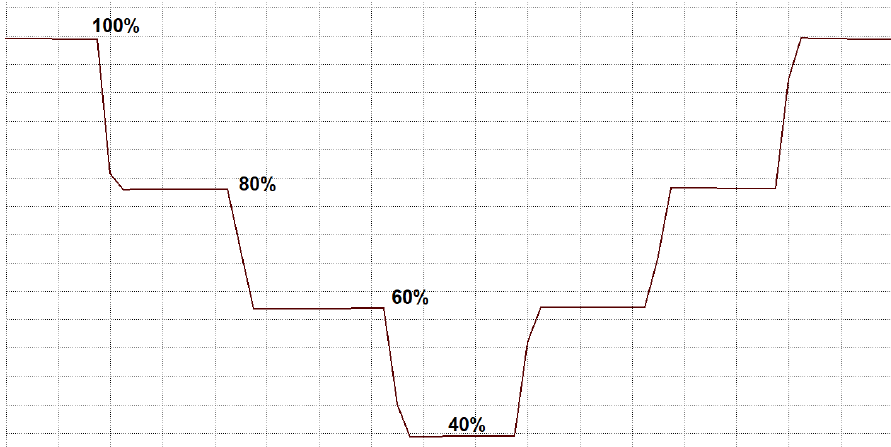
Figure 3. Diagram of reducing the luminous flux at